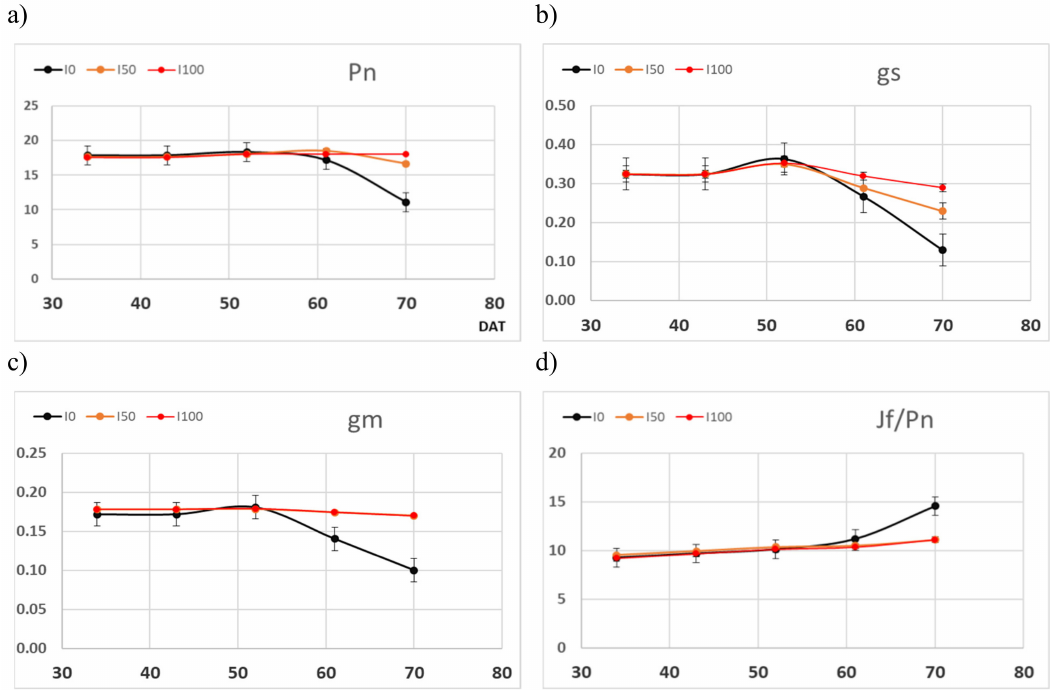
Figure 3. ( a ) Net photosynthesis (P n µ mol m − 2 s − 1 ), ( b )stomatal conductance (g s mol m − 2 s − 1 ), ( c ) mesophyll conductance (g m µ mol m − 2 s − 1 ), and ( d ) J f / P n (relative) of non-water-stressed (I 100